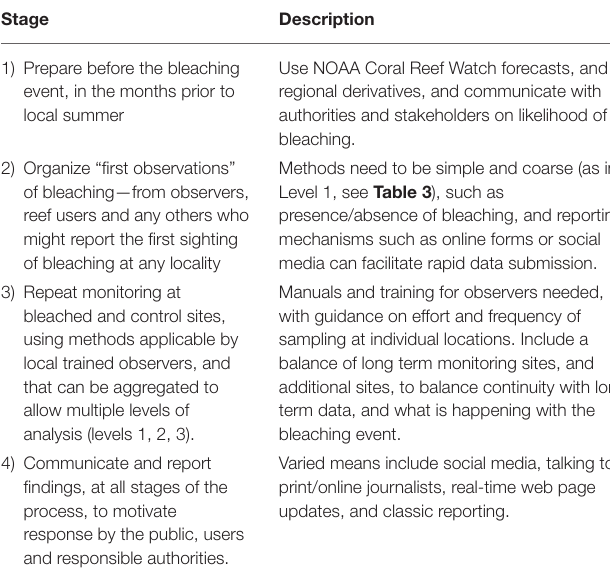
TABLE 4 | Stages in coral bleaching event